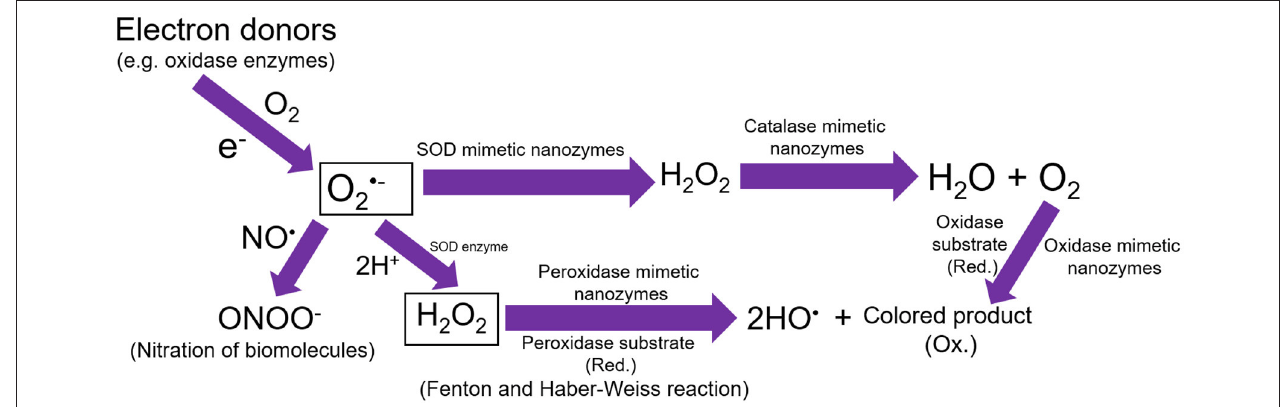
FIGURE 1 | Schematic representation showing that the single electron donors can produce superoxide anions. These superoxide anions could further react with NO or 2H + to produce ONOO − anions and hydrogen peroxide, respectively. The SOD mimetic nanozymes can dismutate the superoxide anions into hydrogen peroxide, which can further be degraded into water and molecular oxygen by catalase mimetic nanozymes. Hydrogen peroxide can also lead to the generation of hydroxyl radicals in presence of peroxidase mimetic nanozymes, however, oxidase mimetic nanozymes can directly oxidize the substrate into colored product without the involvement of hydrogen